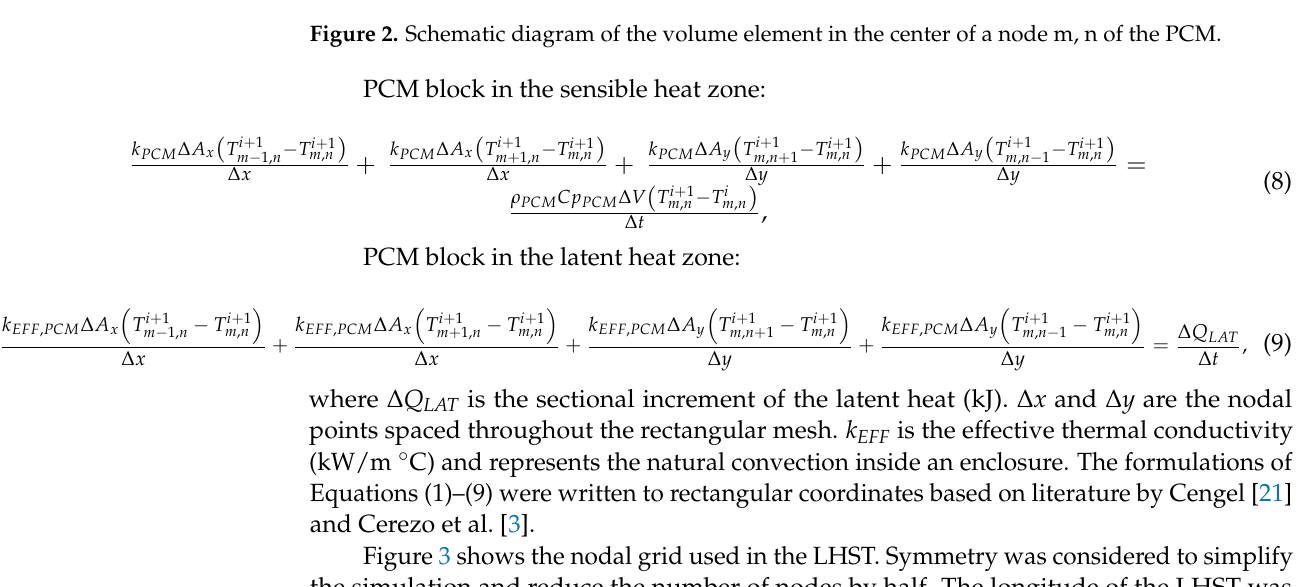
[21] and Cerezo et al. [3].